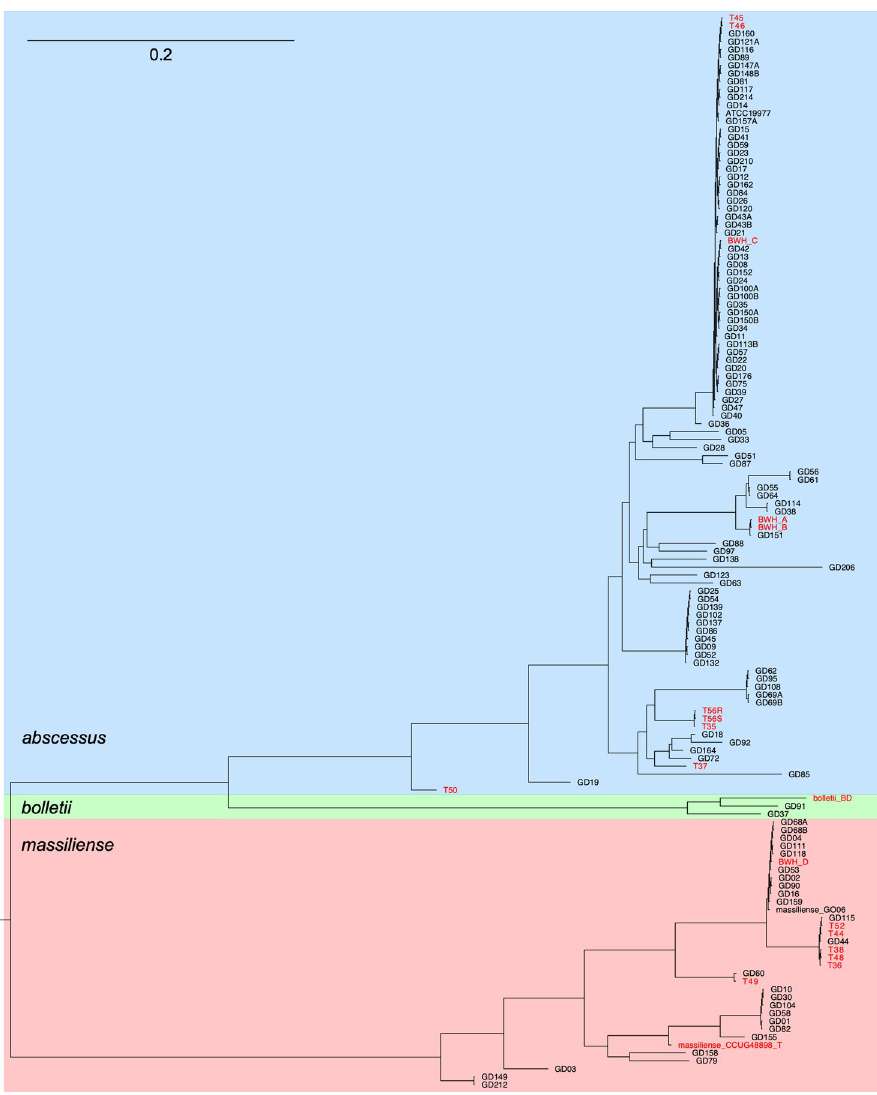
Fig 1. Phylogeny of M . abscessus strains. Phylogenetic relationships of M . abscessus isolates based on 3,350,221 (65.8%) positions conserved in all strains. Subspecies are shaded blue, green, and red for M . abscessus subsp. abscessus , M . abscessus subsp. bolletii , and M . abscessus subsp. massiliense , respectively. Strain names in red type are those discussed further here. Other strains either were reported previously [13] or are our unpublished data. Scale bar corresponds to 0.2 substitutions per